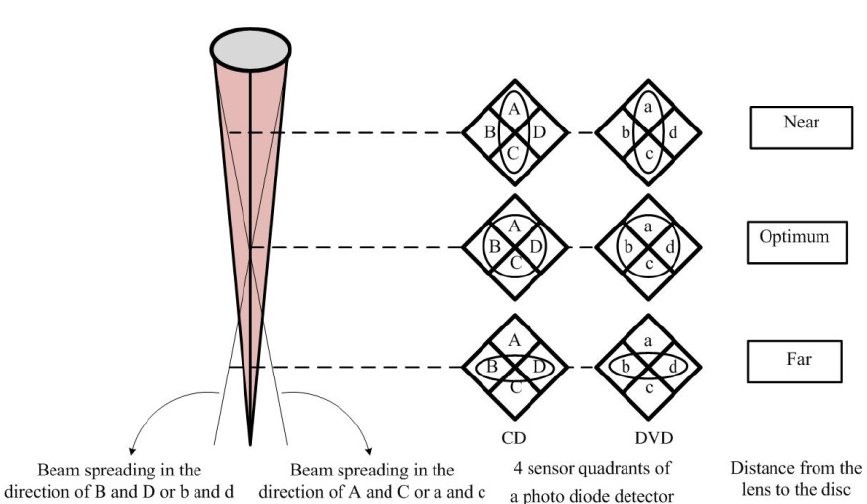
Figure 2. Developed focus error signal of the CD / DVD pick-up head.